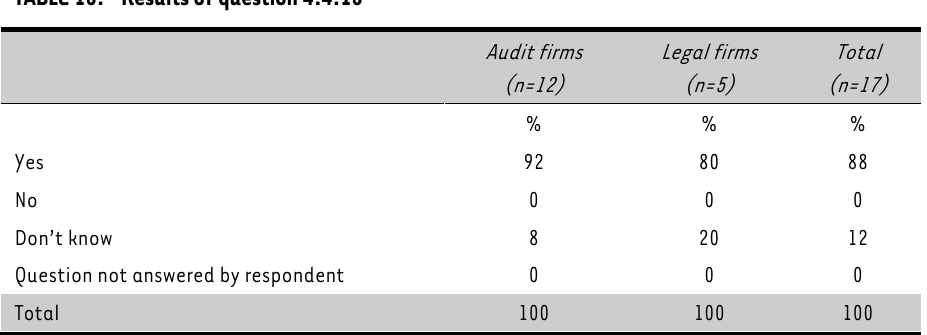
TABLE 15: Results of question